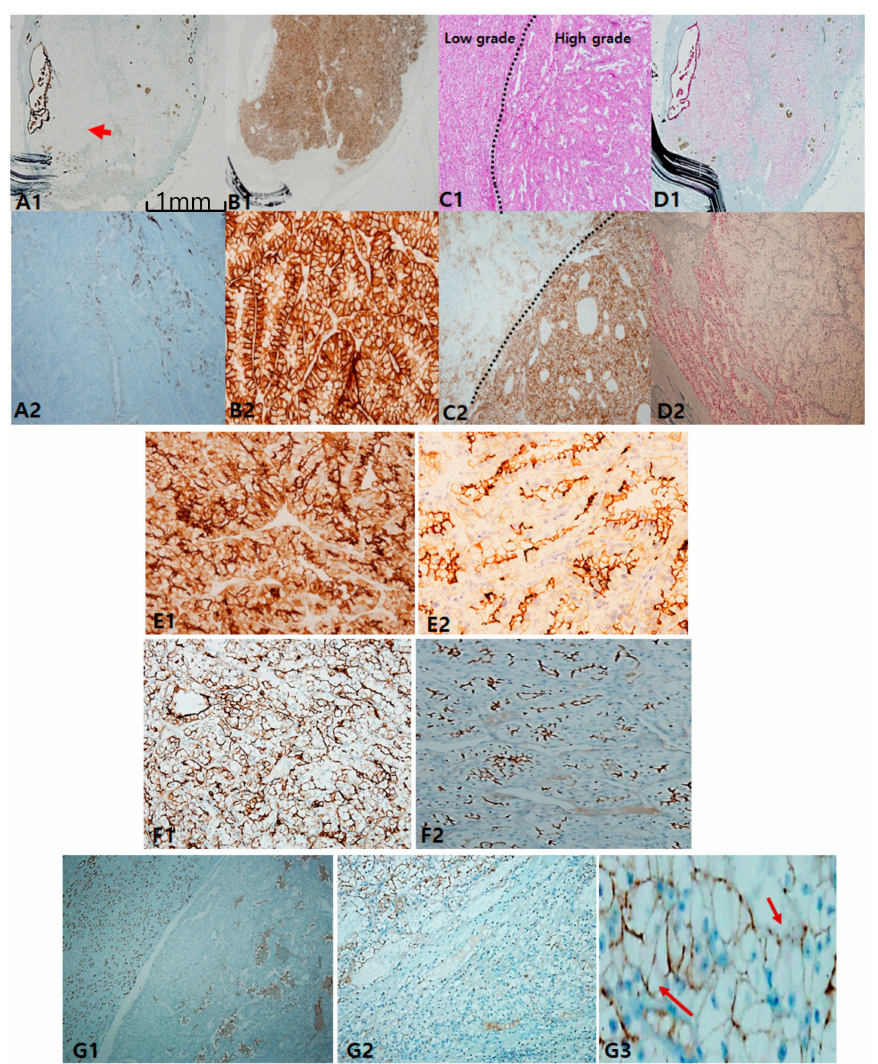
Figure 1. Classic immunopanels for clear-cell renal cell carcinoma (CCRCC). ( A1 , A2 ) cytokeratin 7 labeling is mostly negative but exceptionally positive in macrocystic tubules (arrow). ( B1 , B2 ) Carbonic anhydrase IX (CAIX) is always positive as a box pattern, which is a pathognomonic sign. ( C1 , C2 ) CAIX labeling tends to be stronger and more di ff use in higher grades (grade 3–4) than in lower ones (grade 1–2). ( D1 , D2 ) Alpha-methylacyl-CoA racemase is variably positive but less intense than in papillary renal cell carcinoma (PRCC). Adjuvant immunopanels of CCRCC. ( E1 , E2 ) In CCRCC, immunoreactivities of epithelial membrane antigen and CD10 are closely correlated. EMA is more exaggerated (E1) and CD10 expression occurs in a saw-tooth luminal pattern ( E2 ). ( F1 , F2 ) EMA ( F1 ) labeling recapitulates exaggerated CD10 ( F2 ) expression. ( G1–G3 ) E-cadherin expression is frequently lost ( G1 , G2 ) or occasionally broken (arrows) ( G3 ). Scale bars = 1